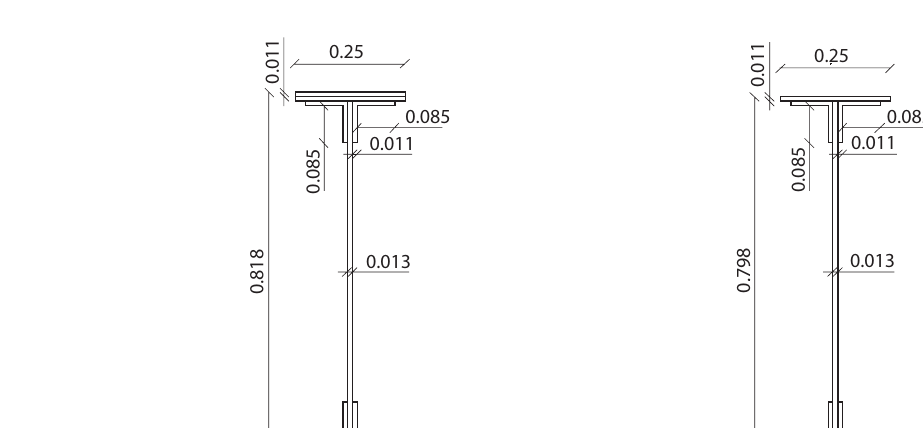
Fig. 2. Geometrical survey of the Meschio Bridge (Pipinato 2008)